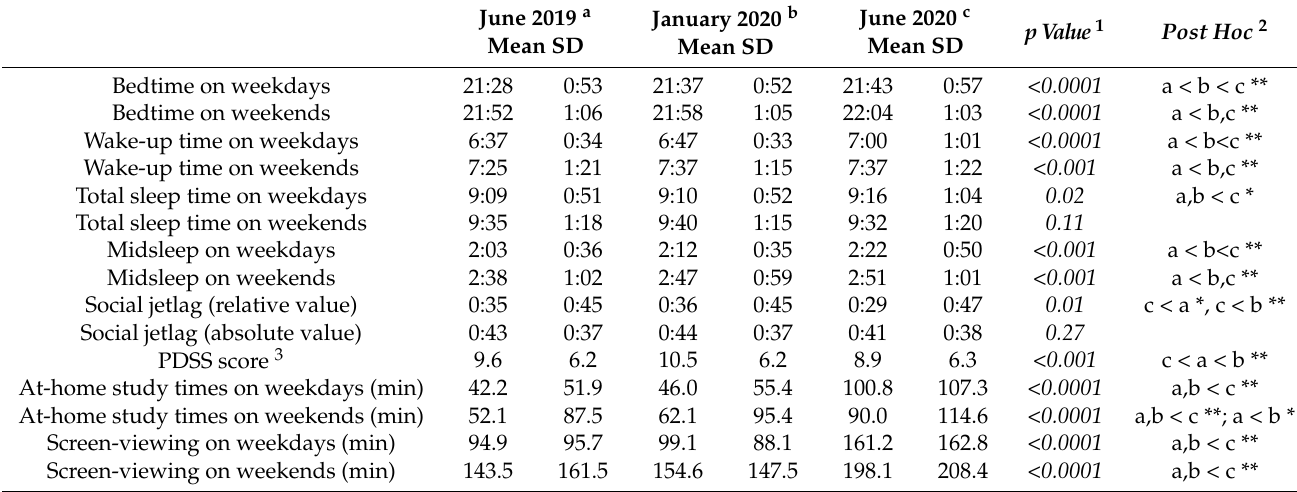
Table 3. Comparison of sleep habits and other variables at the three survey points in pupils who responded to all three surveys.